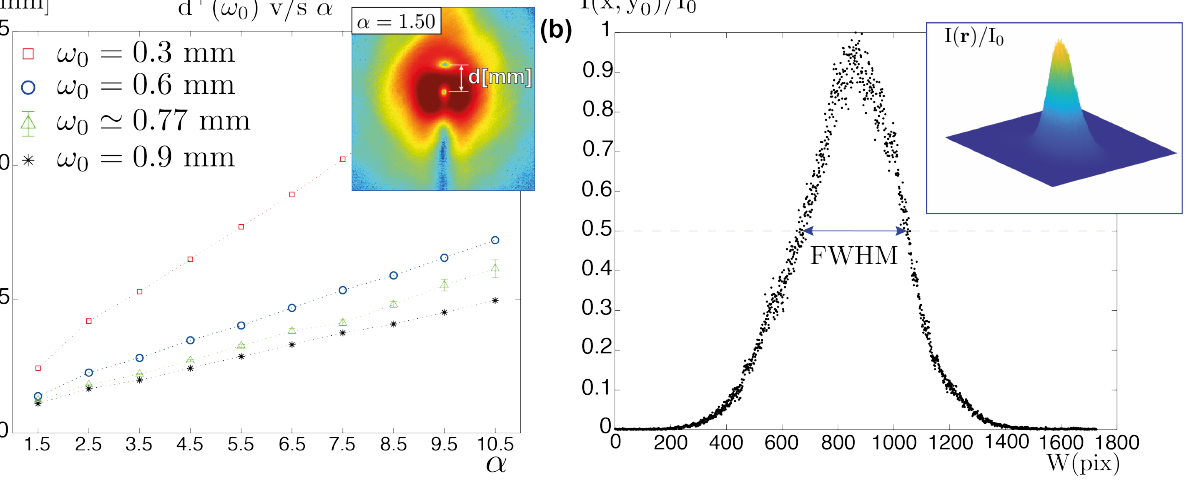
Figure 3. Distances of resident vortices v r with fractional steps of 0.5. ( a ) Numerical simulations for different waists ω 0 : 0.3 (red square), 0.6 (blue circle), and 0.9 mm (black asterisk). Experimental results (green triangle) for the measured waist ω 0 = 0.77 mm. Top right: focal plane intensity profile sample (logarithmic scale) for α = 1.50. ( b ) Experimental Gaussian beam profile (HeNe,THORLABS HNL100L, λ = 632.8 nm).